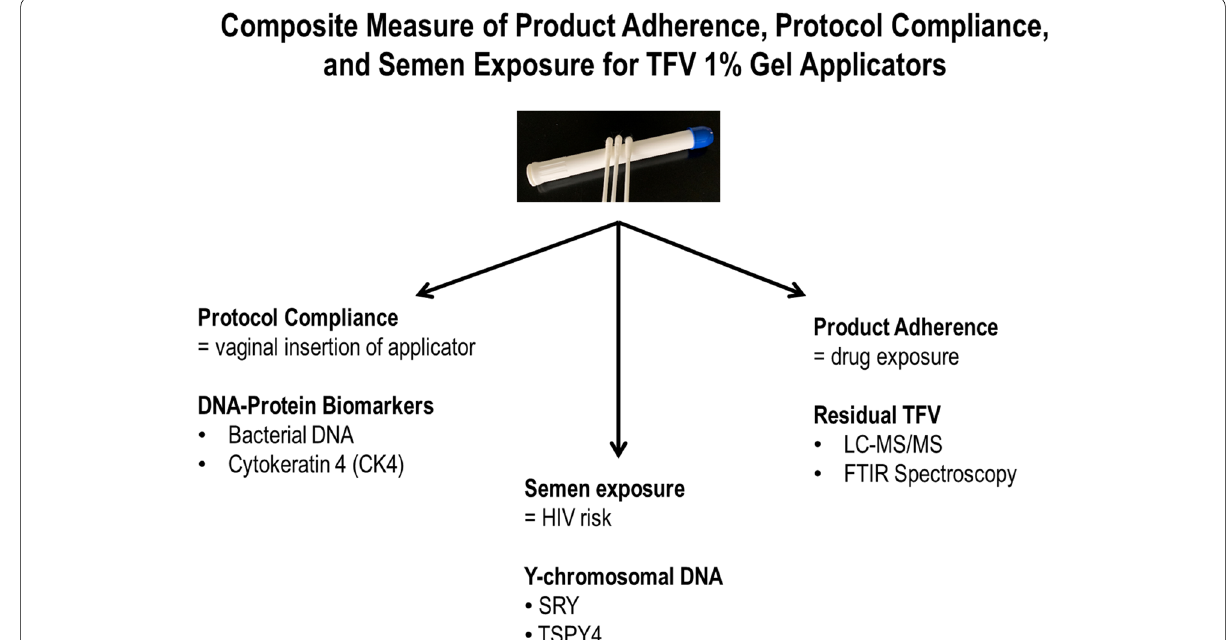
Fig. 1 Individual elements of the composite measure of adherence, protocol compliance, and semen exposure. Returned, used TFV 1% gel applicators were swabbed with three swab heads to capture biomarkers and residual drug on the barrel of the applicator. The first swab head was used to detect of vaginal bacterial DNA and y‑chromosomal DNA. The second swab head was used to detect the presence of CK4 in vaginal cells left on the applicator. The third swab head was used for detecting residual TFV by LC–MS/MS and FTIR spectroscopy. More details have been previously published [10,